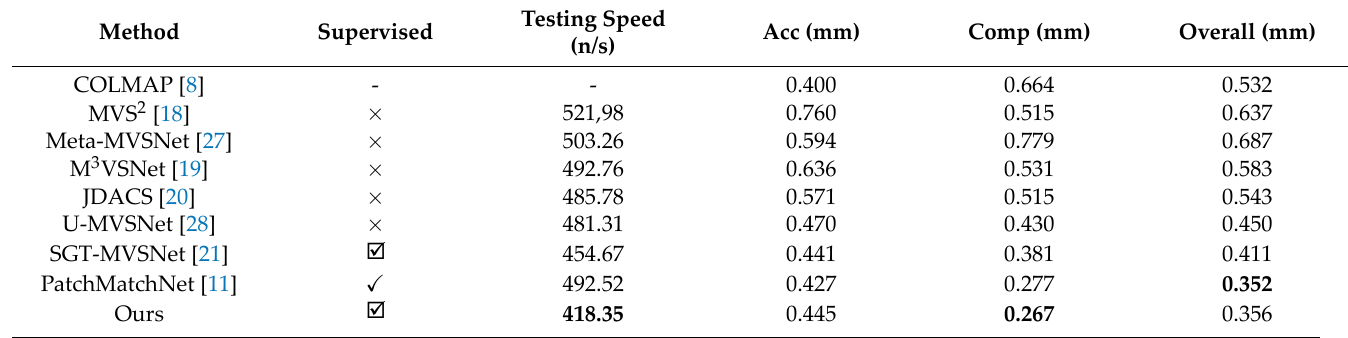
Table 1. Qualitative comparison table of each comparison algorithm in DTU . × is unsupervised. ✓ is supervised. is semi-supervised.